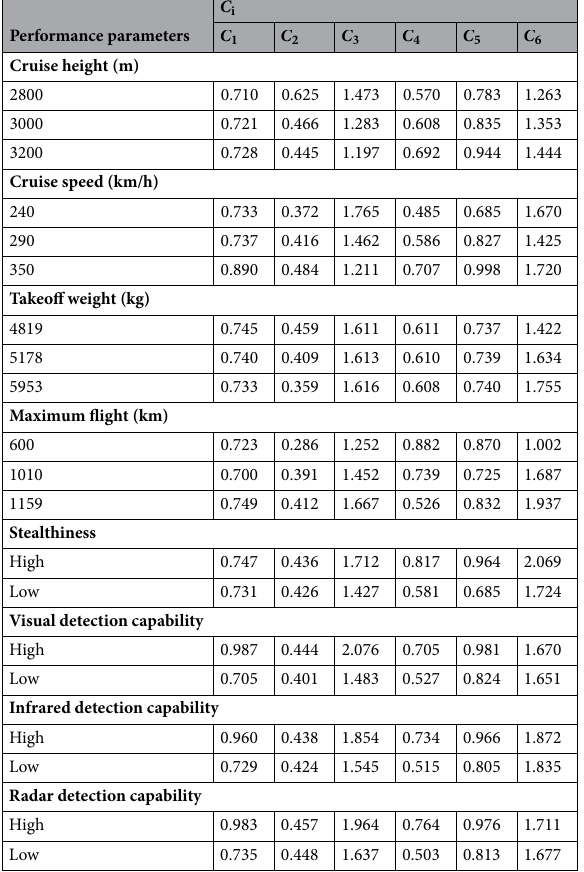
inf C i inf C 1 inf C 2 inf C 3 inf C 4 inf C 5 inf C 6 inf